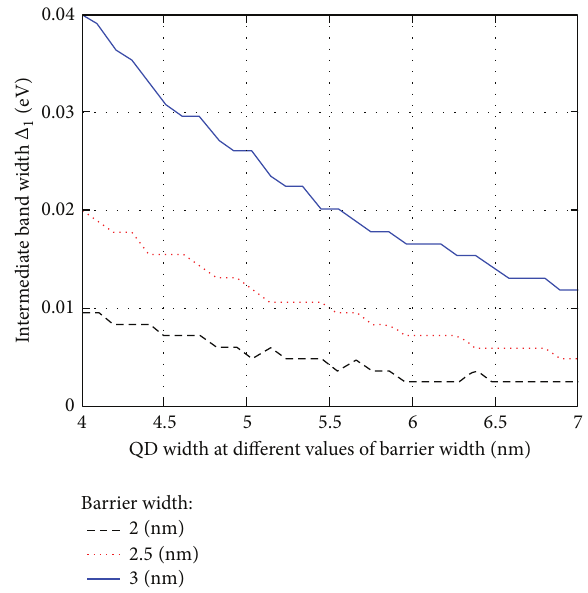
Figure 6: Change width of intermediate band ( Δ 1 ) with change QD width for the first allowable range at three different values of barrier